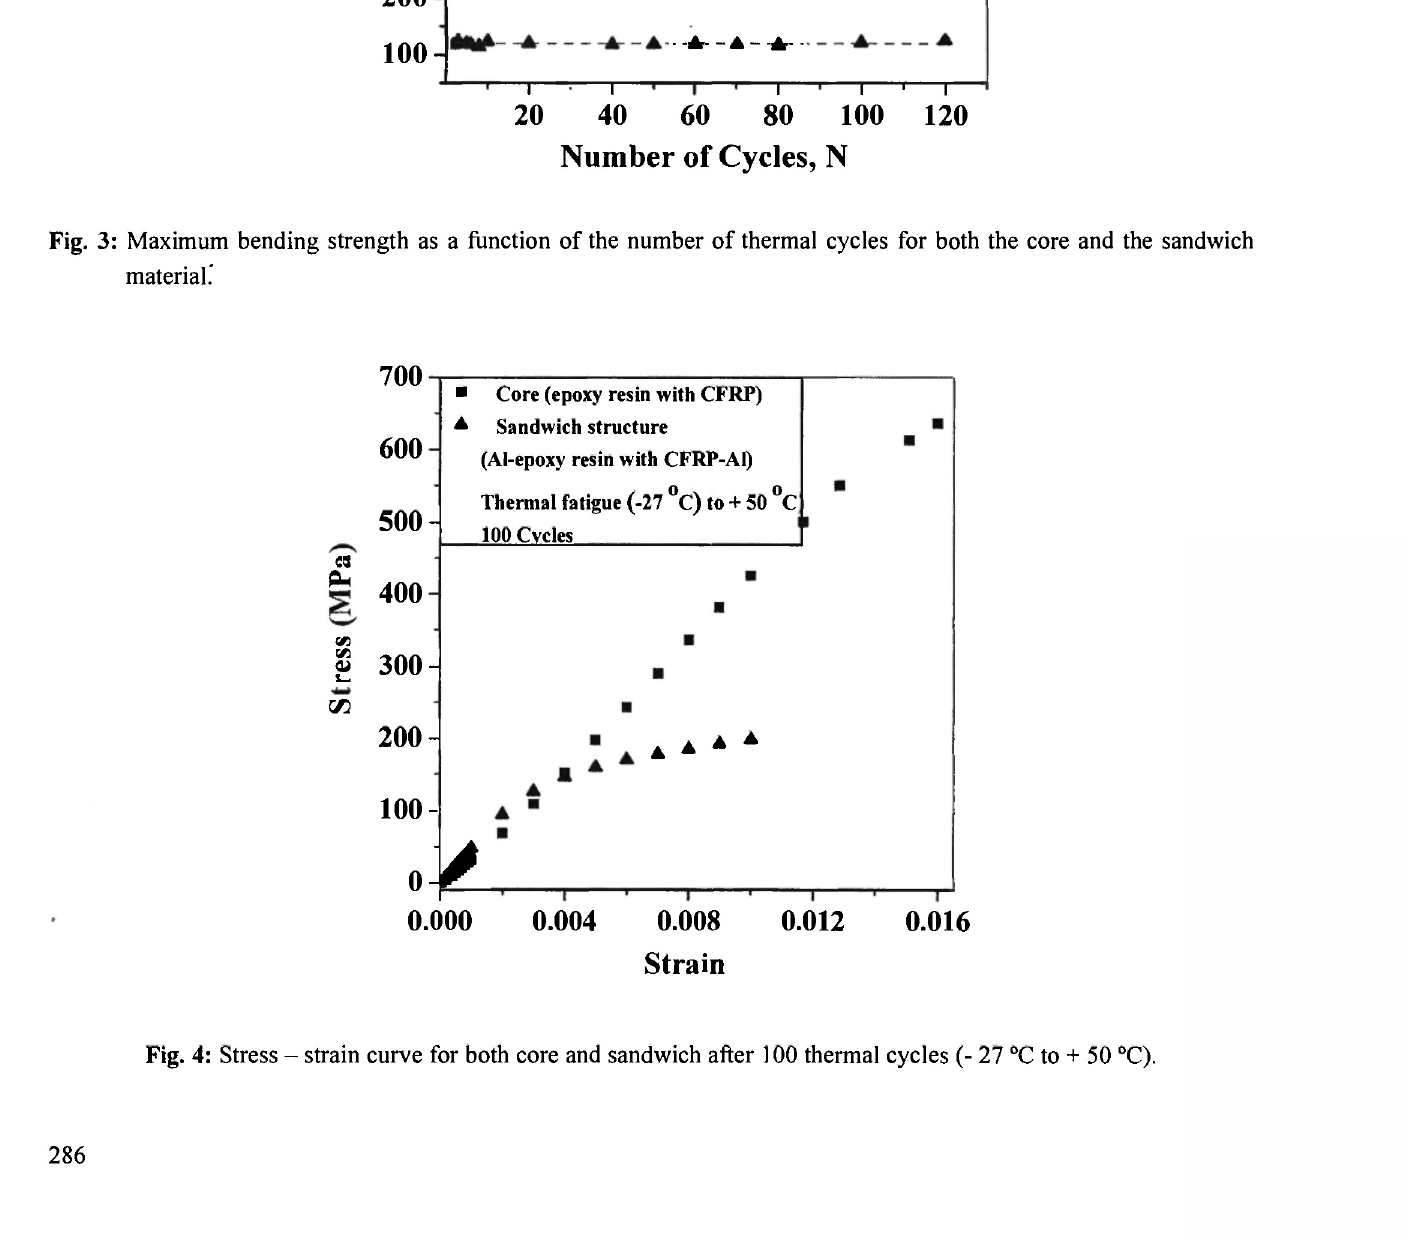
Fig. 4: Stress - strain curve for both core and sandwich after 100 thermal cycles (- 27 °C to + 50 °C).